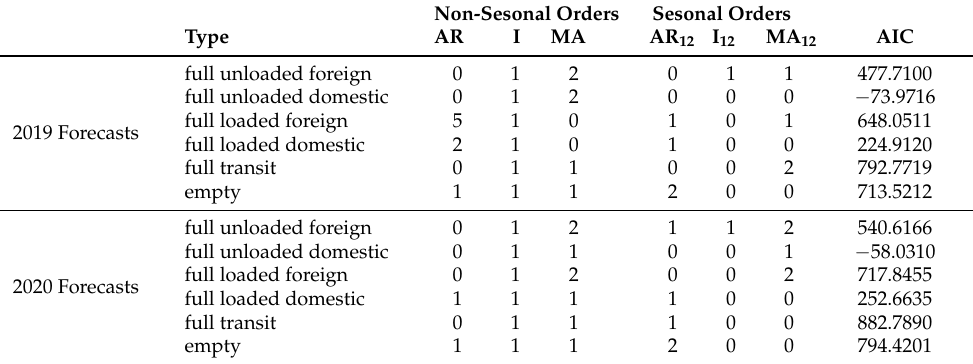
Table 2. Best SARIMA models